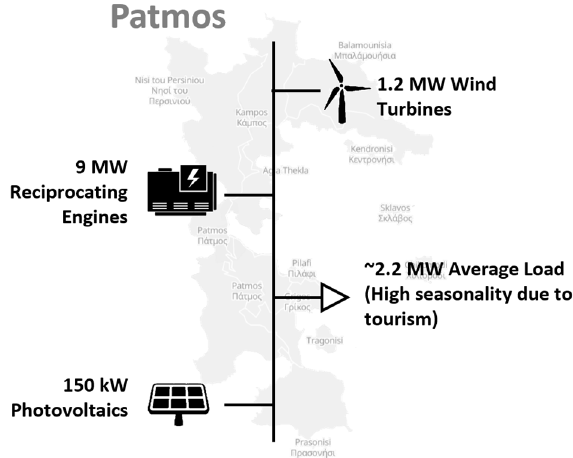
Figure 2. Installed generation capacities in Patmos.